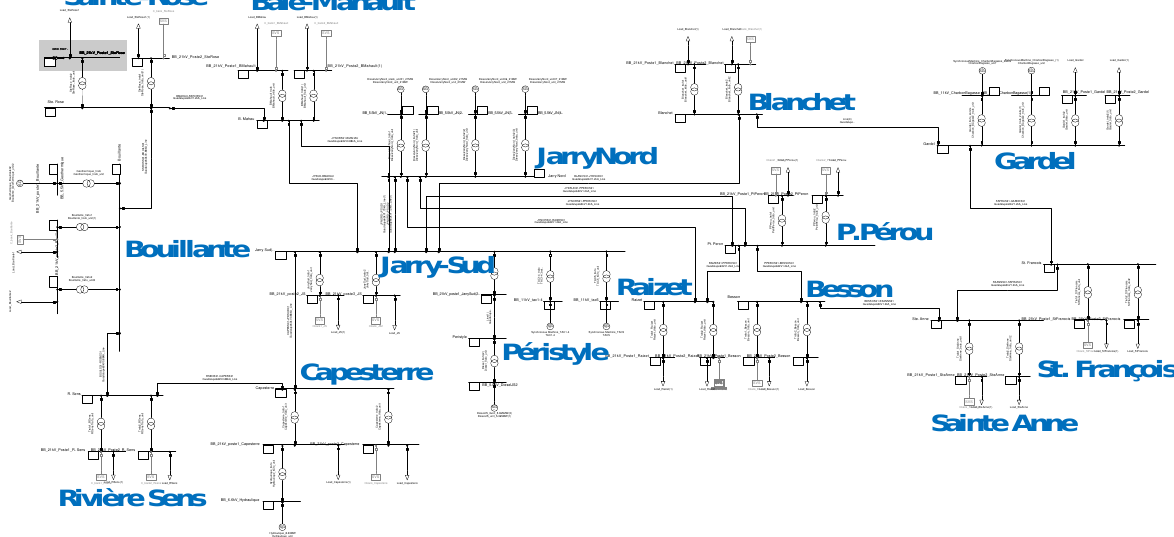
Figure 2. Guadeloupe’s PowerFactory electric grid model. The wind-BESS hybrid power plant is depicted Figure 3. The wind generation system comprises four 2 MW wind turbines with their respective converters and transformers. Meanwhile, the BESS consists of four storage units connected in parallel (1 MW/580 kWh capacity by unit), with their respective converters and transformers.